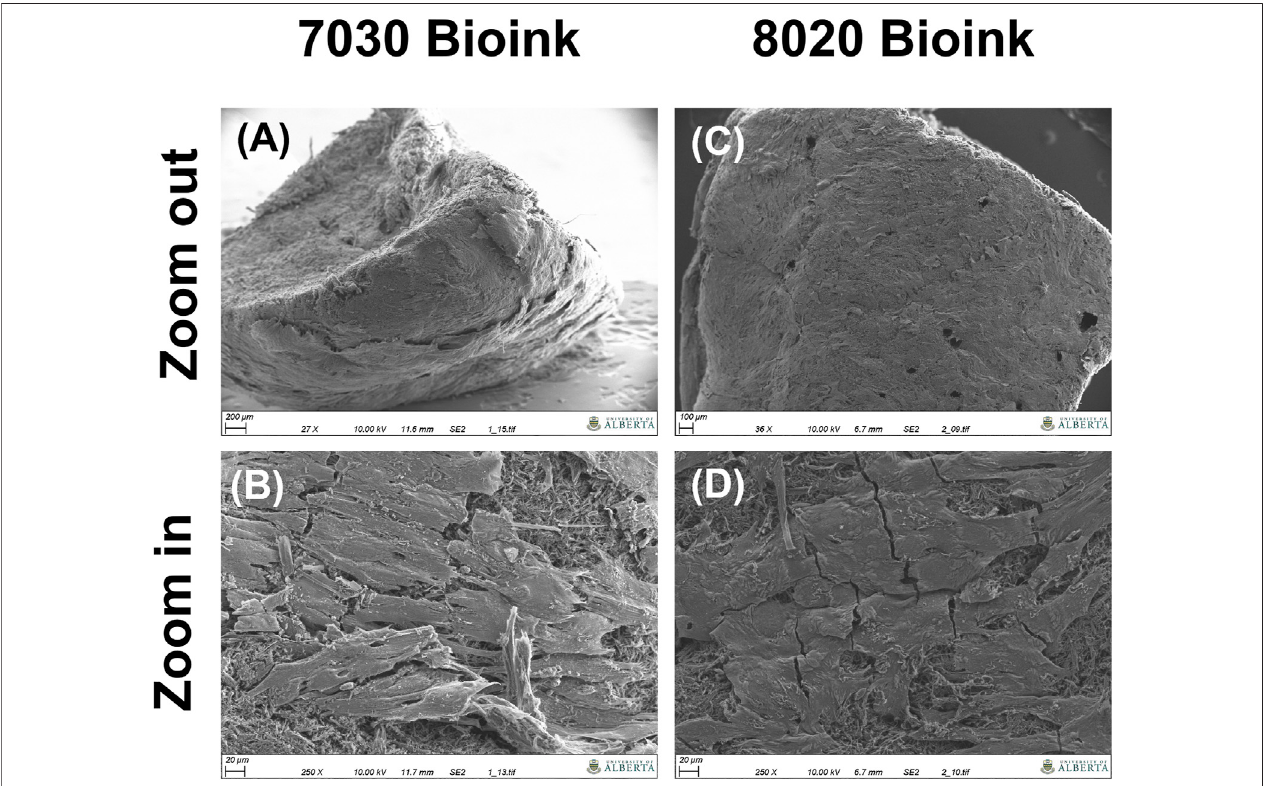
FIGURE 7 | SEM images of the bioprinted constructs after 6 weeks of in vitro culture, (A,B) the cross-section of the 7030 bioink (C,D) surface of the 7030 bioink.